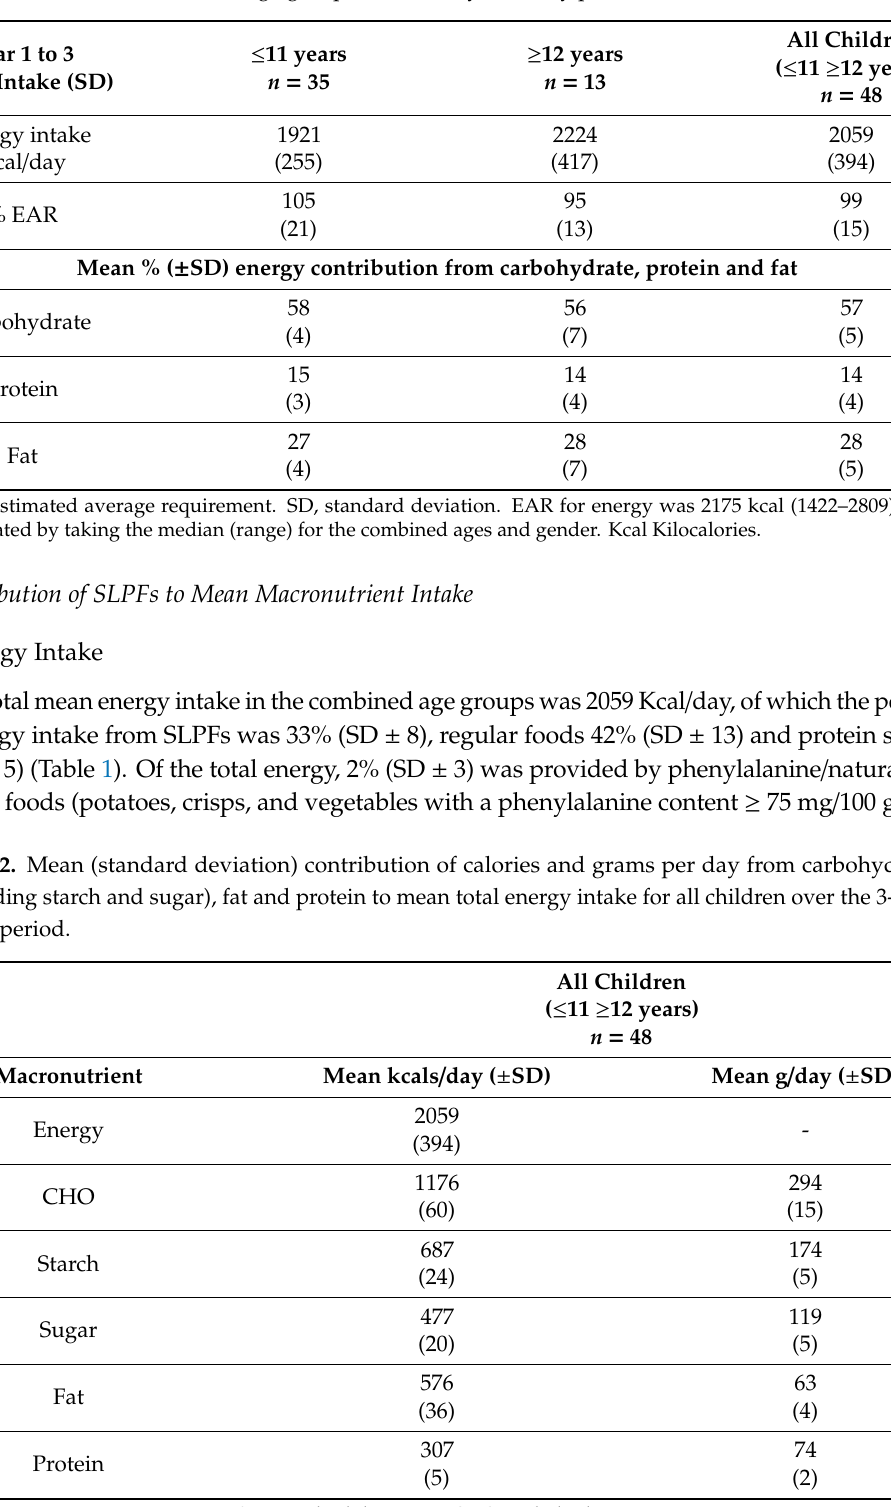
Table 1. Mean (standard deviation) total energy intake, percentage of EAR, and the contribution of carbohydrate, protein and fat as a percentage of mean total energy intakes in children ≤ 11 years and ≥ 12 years, and for the combined age groups over the 3-year study period.